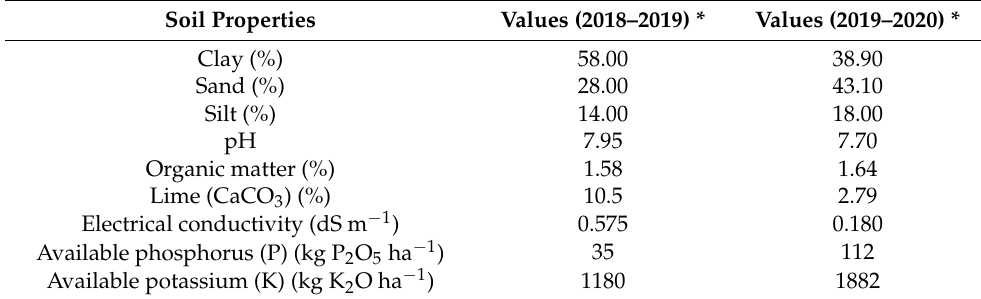
Table 2. Some physical and chemical soil properties of the trial fields. Soil